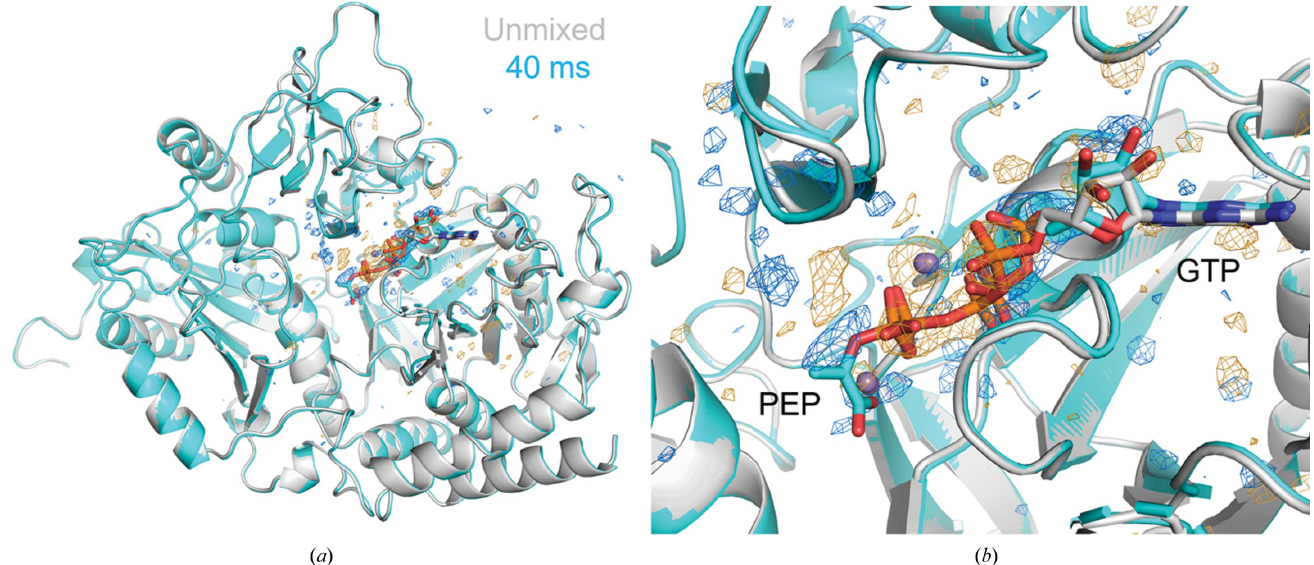
Figure 2 MMQX experiments show evidence for the diffusion of OAA into the PEPCK active site and formation of the PEP product. F o (cid:4) F o analysis of 40 ms (cyan model) (cid:4) unmixed (gray model) PEPCK data. F o (cid:4) F o maps shown at (cid:6) 3.5 r.m.s.d. (blue, orange). ( a ) Overview of the asymmetric unit demonstrating that large difference-map peaks are concentrated in the active site. ( b ) View of the active site, showing difference-map peaks for PEP and relaxation of